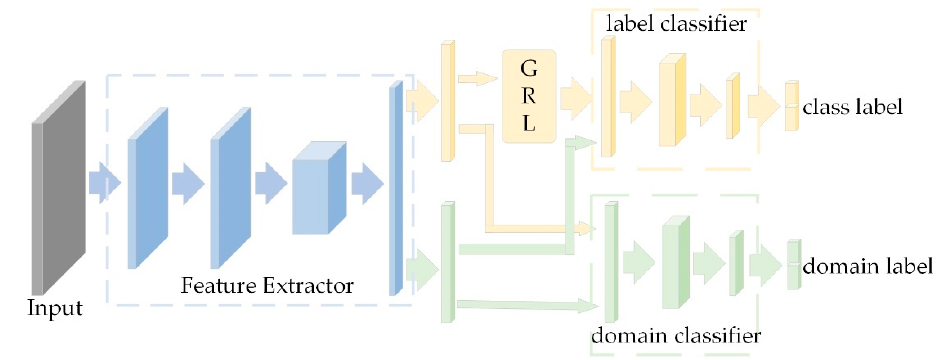
Figure 3. Architecture of adversarial mechanism; GRL: gradient reversal layer Feature extractor: This part extracts features and decomposes them into image con-